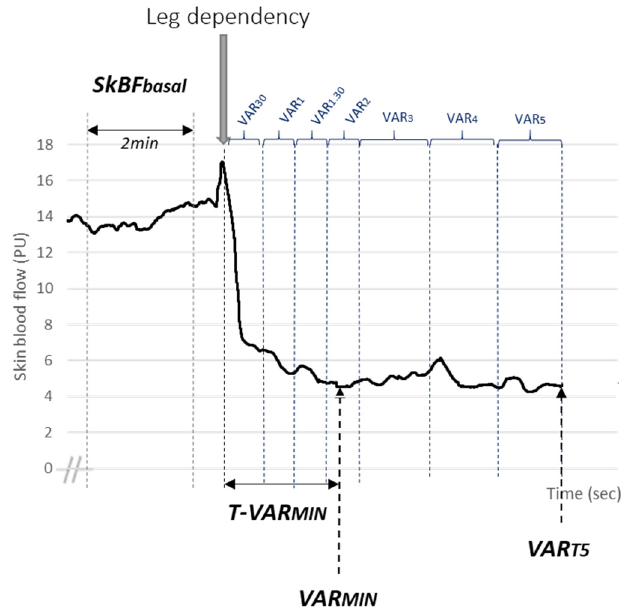
Figure 1. Representation of analyzed parameters. SkBF, skin blood flow.